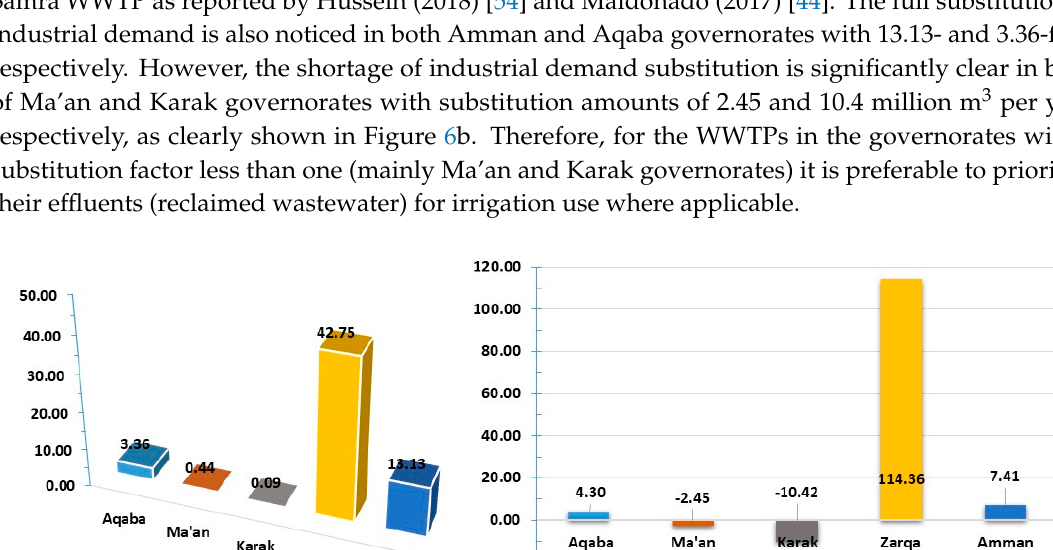
Figure 6. Reclaimed wastewater substitution in major industries in Jordanian governorates: ( a ) substitution factors, and ( b ) substitution amounts (million m 3 per year).